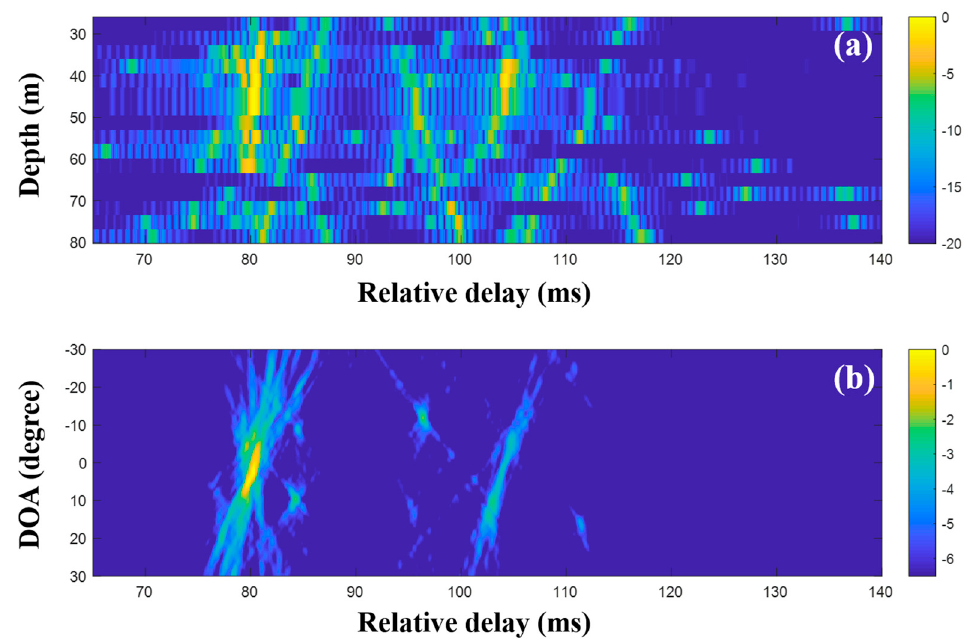
Figure 12. Direction-of-arrival (DOA) estimation using compressive sensing (CS) with a single snapshot captured by the vertical line array (VLA) in SAVEX15 (0.5–2 kHz): ( a ) arrival structures via sequential CS usage to the signals at the VLA, and ( b ) DOAs using delay-and-sum beamforming with the arrival structures.